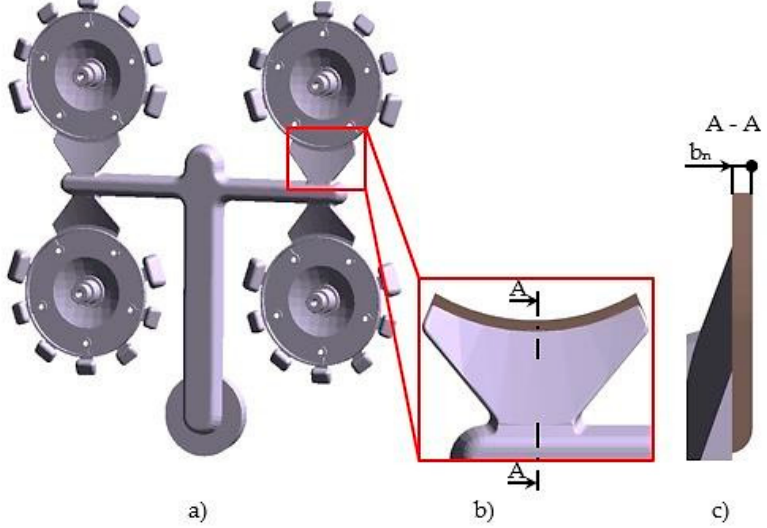
Figure 2. Structural design of the gating system and of the gate ( a , b ) the structural design of the connection of the casting to the gating system by means of a gate and its shape ( c ) the gate height.